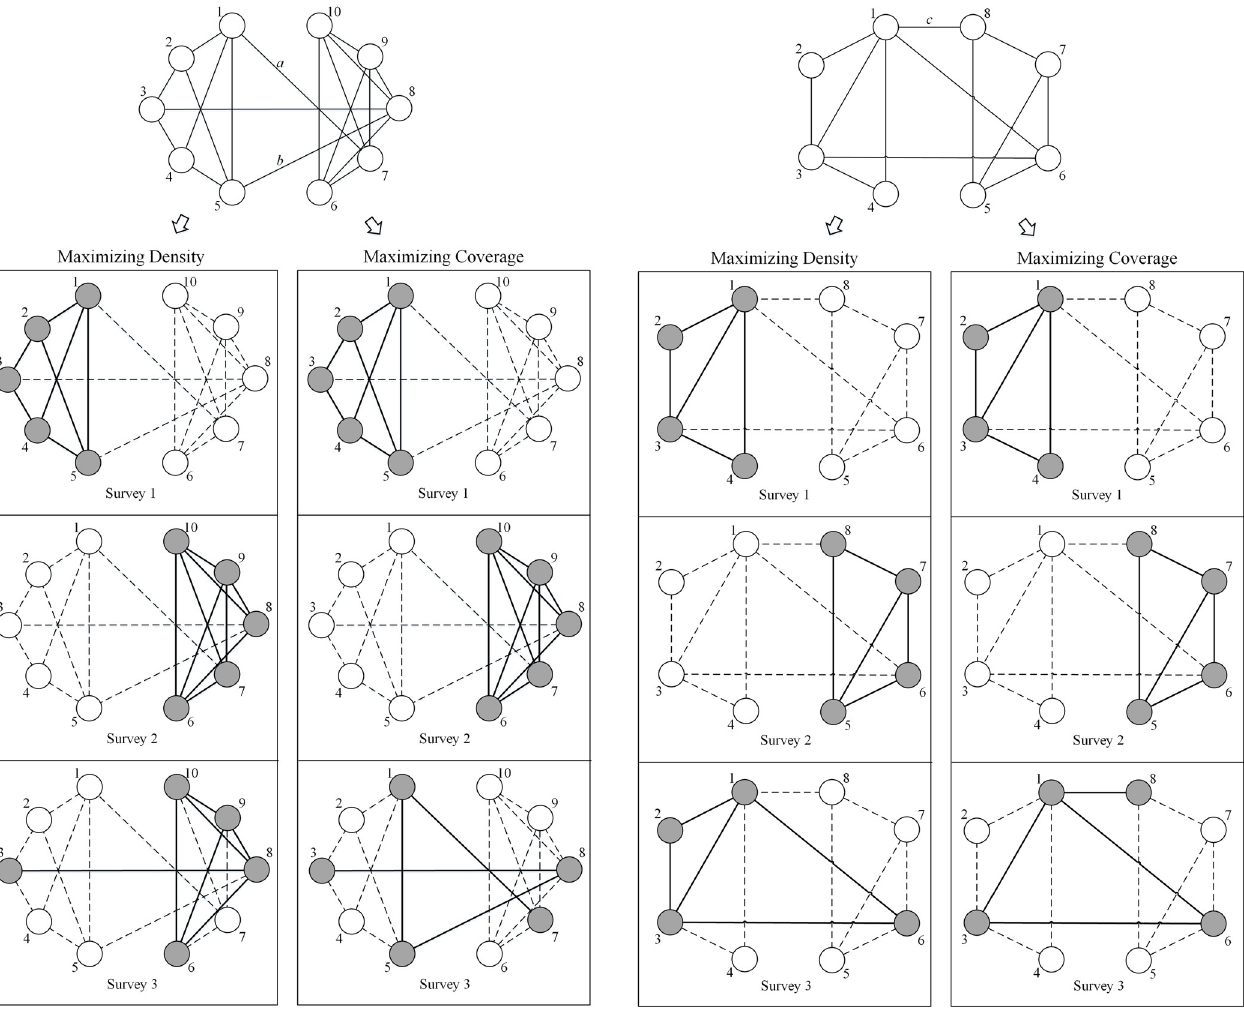
Fig 1. Two illustrations of the difference between maximizing the density and the coverage. The upper two networks are the input networks. The lower part contains the solution of extracting multiple subgraphs. In the solution part, grey nodes represent the included nodes and white nodes represent the omitted nodes. The dashed lines represent the unobserved ties, while the bold solid lines represent the extracted